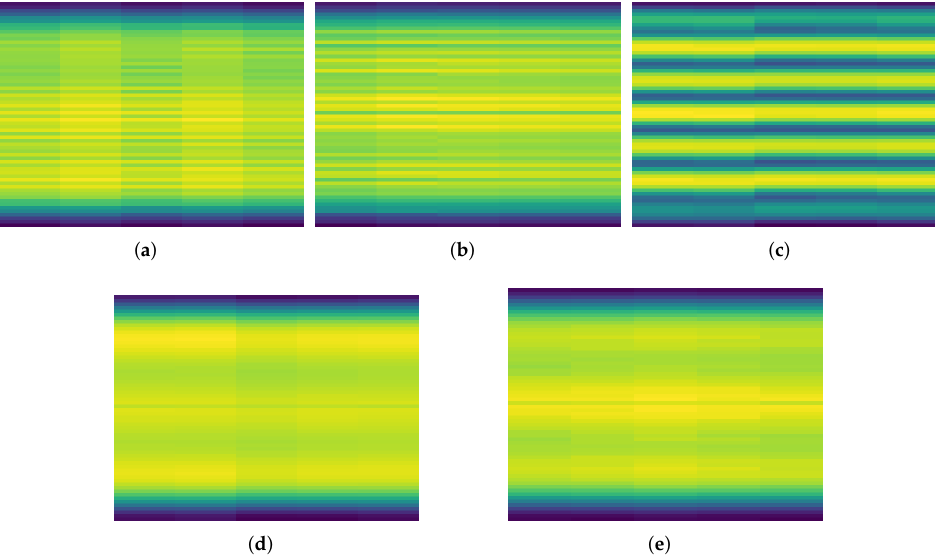
Figure 12. Spectrograms of 5 s of signals, yellow is high power and blue is low power. The signals of the interference signals are 10 to 30 MHz wide, but the sensor node records only a bandwidth of 2.56 MHz so it can see a small portion of the signal. The signals are labeled as Interference signal type 1 to type 4 ( a – d ), and None (signal without interference signals) ( e